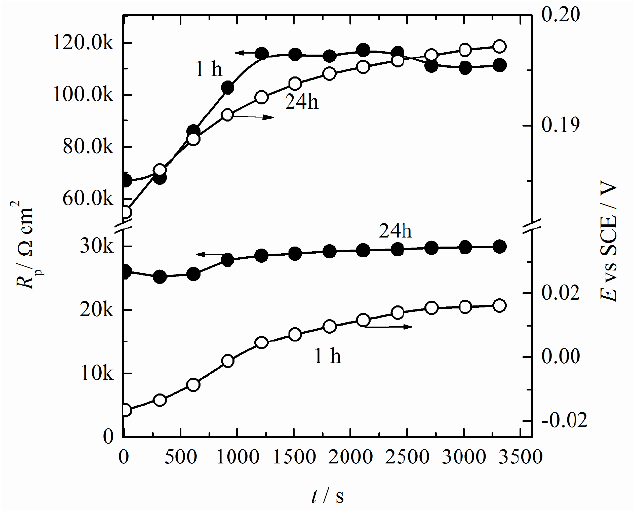
Figure 4. The dependence of the open-circuit potentials (right axis) and polarization resistance (left axis) after initial immersion ( • ) and after 24 h (o) of immersion in 0.9 wt.%